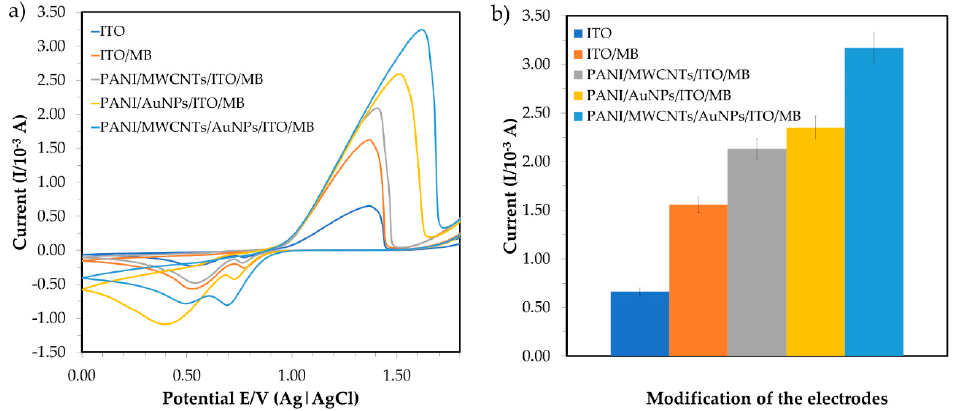
Figure 4. Comparison of electrochemical behavior for bare ITO, PANI / MWCNTs / ITO, PANI / AuNPs / ITO and PANI / MWCNTs / AuNPs / ITO in the presence of methylene blue (MB) as a redox indicator; ( a ) cyclic voltammogram and ( b ) the corresponding peak current.